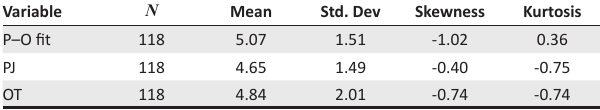
TABLE 1: Descriptive statistics of the variables.